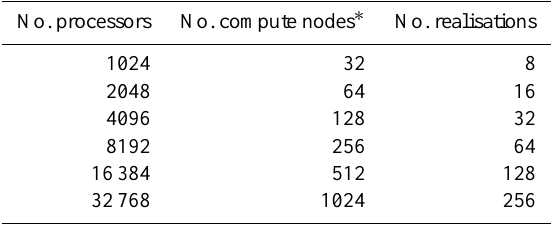
Table 1. Number of processors, compute nodes and realisation used in the weak scaling study for TerrSysMP–PDAF on JUQUEEN. Each realisation was computed with a constant number of proces- sors for ParFlow (96) and CLM